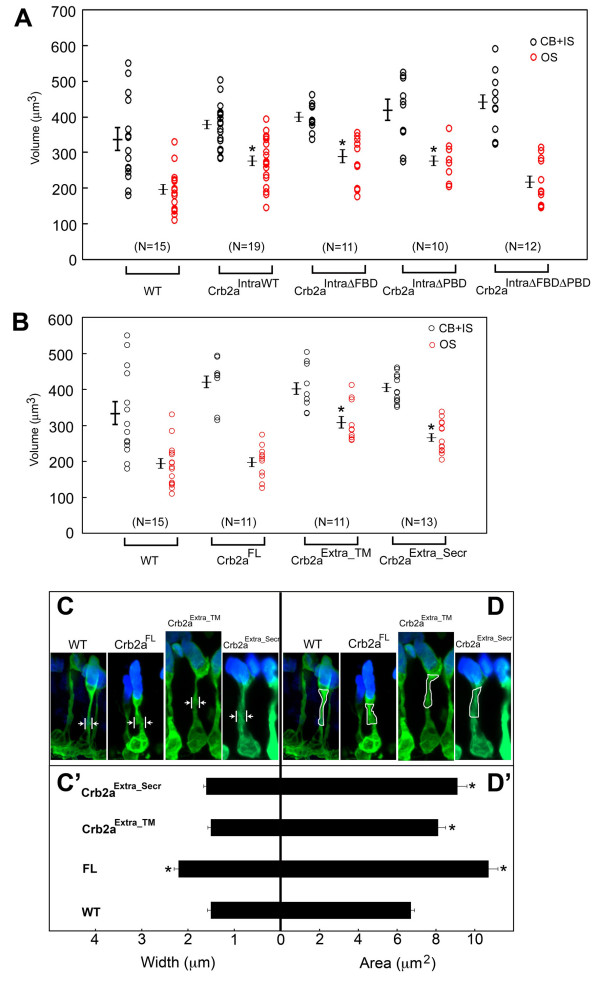
Measurement of rod size in Crb2a transgenics. (A) The average combined volume of rod cell body and inner segment (black circles) measured 332 ± 30 μm3 (wildtype), 372 ± 13.6 μm3 (Crb2aIntraWT), 394 ± 12.2 μm3 (Crb2aIntraΔFBD), 416 ± 28.9 μm3 (Crb2aIntraΔPBD), and 436 ± 22.8 μm3 (Crb2aIntraΔFBDΔPBD). The average volume of a rod outer segment (red circles) measured 190 ± 15.7 μm3 (wildtypes), 277 ± 15.4 μm3 (Crb2aIntraWT), 283 ± 20.6 μm3 (Crb2aIntraΔFBD), 278 ± 15.9 μm3 (Crb2aIntraΔPBD), and 212 ± 18.9 μm3 (Crb2aIntraΔFBDΔPBD). (B) The average combined volume of rod cell body and inner segment (black circles) measured 332 ± 30 μm3 (wildtype), 426 ± 17.5 μm3 (Crb2aFL), 401 ± 17.8 μm3 (Crb2aExtra_TM), and 405 ± 11 μm3 (Crb2aExtra_Secr). The average volume of a rod outer segment (red circles) measured 190 ± 15.7 μm3 (wildtype), 198 ± 13.8 μm3 (Crb2aFL), 316 ± 17.2 μm3 (Crb2aExtra_TM), and 268 ± 12.1 μm3 (Crb2aExtra_Secr). (C, C') Width of the inner segment myoid region was marked as in (C) and the measurements are shown in (C'). The width of the myoid region is significantly larger in Crb2aFL rods (2.2 ± 0.1 μm) than wildtypes (1.5 ± 0.08 μm). Crb2aExtra_TM (1.5 ± 0.07 μm) and Crb2aExtra_Secr (1.6 ± 0.06 μm) are similar to wildtypes. (D, D') Area of the myoid region was outlined as in (D) and the measurements are shown in (D'). The area of the myoid region is significantly larger in Crb2aFL (10.7 ± 0.5 μm2), Crb2aExtra_TM (8.1 ± 0.4 μm2), and Crb2aExtra_Secr (9.1 ± 0.5 μm2) compared to wildtypes (6.7 ± 0.2 μm2). Each circle represents a measurement of a single rod. Shown values are mean ± s.e.m, *, p < 0.005, student's t test.